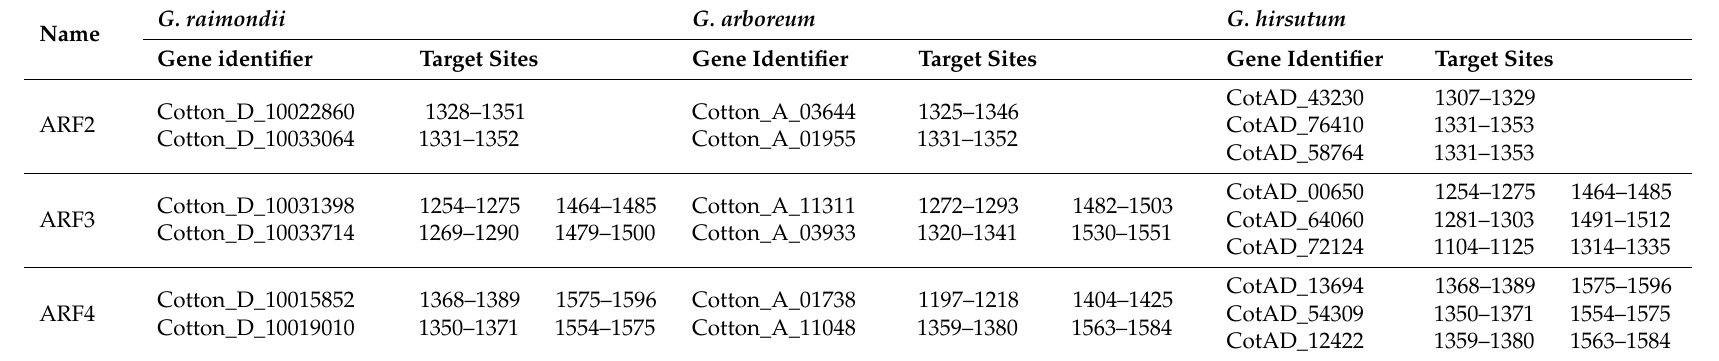
Table 5. List of the ARF2 , ARF3 and ARF4 in three Gossypium species and the target sites for